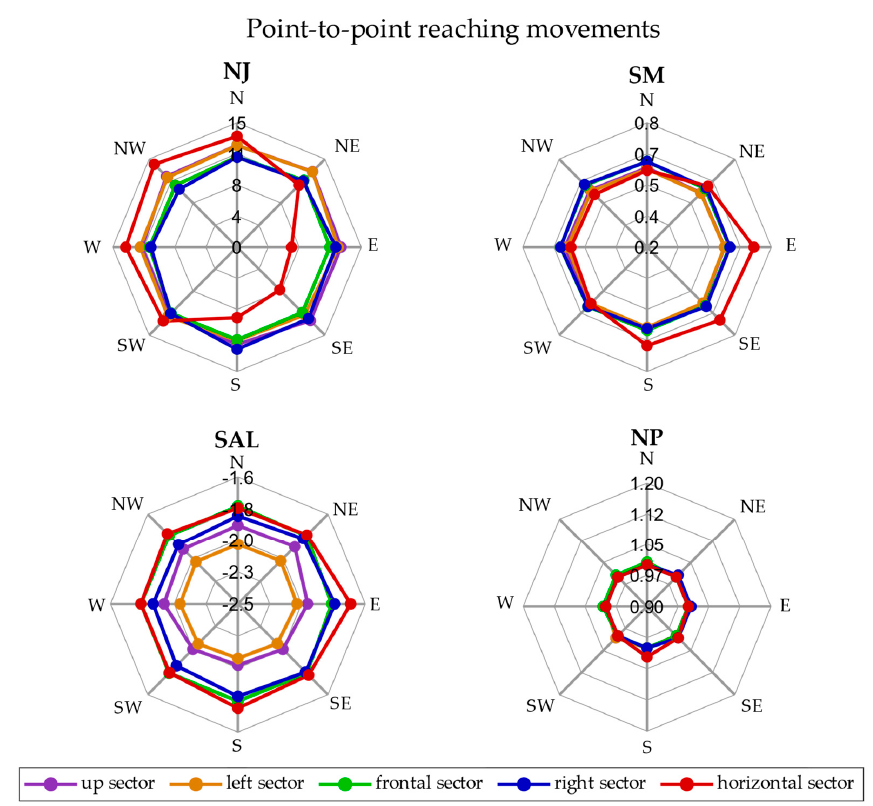
Figure 3. Radar plot for P2P movements. The smoothness metrics are represented in separate plots. In each radar plot, the five sectors—up (purple), left (orange), frontal (green), right (blue) and horizontal (in red)—are reported and each point is the average of the metric across repetitions and subjects.